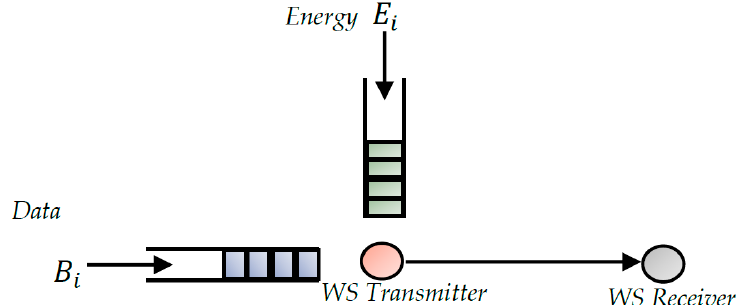
Figure 20. Energy harvesting communication model for solving TCTM problem.